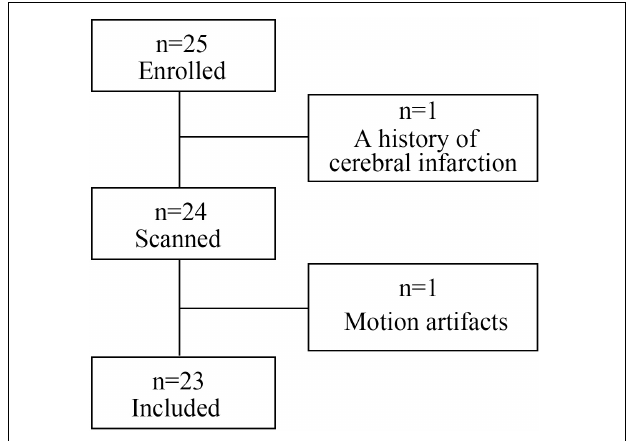
FIGURE 1 | Patient flow diagram.